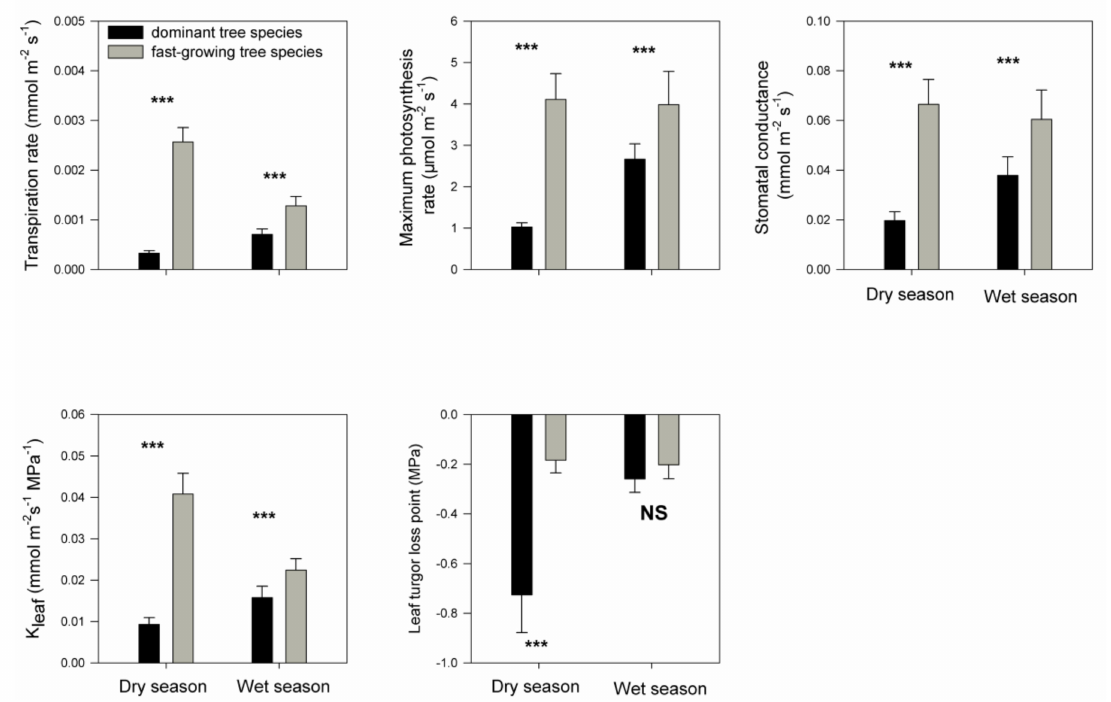
Figure 4. Differences in each of the five hydraulic traits (transpiration rate (TR), maximum photosynthesis rate (Amass), stomatal conductance (SC), leaf hydraulic conductivity (LHC), and leaf turgor loss point (TLP)) between the fast-growing species used for reforestation and the dominant slow-growing species in the adjacent undisturbed tropical rain forest in the dry and the wet seasons, respectively. *** indicates p < 0.05 and NS (nonsignificant) indicates p > 0.05 based on a generalized linear mixed e ff ect model with Poisson error family. Bars indicate the mean values, and error bars denote standard errors.